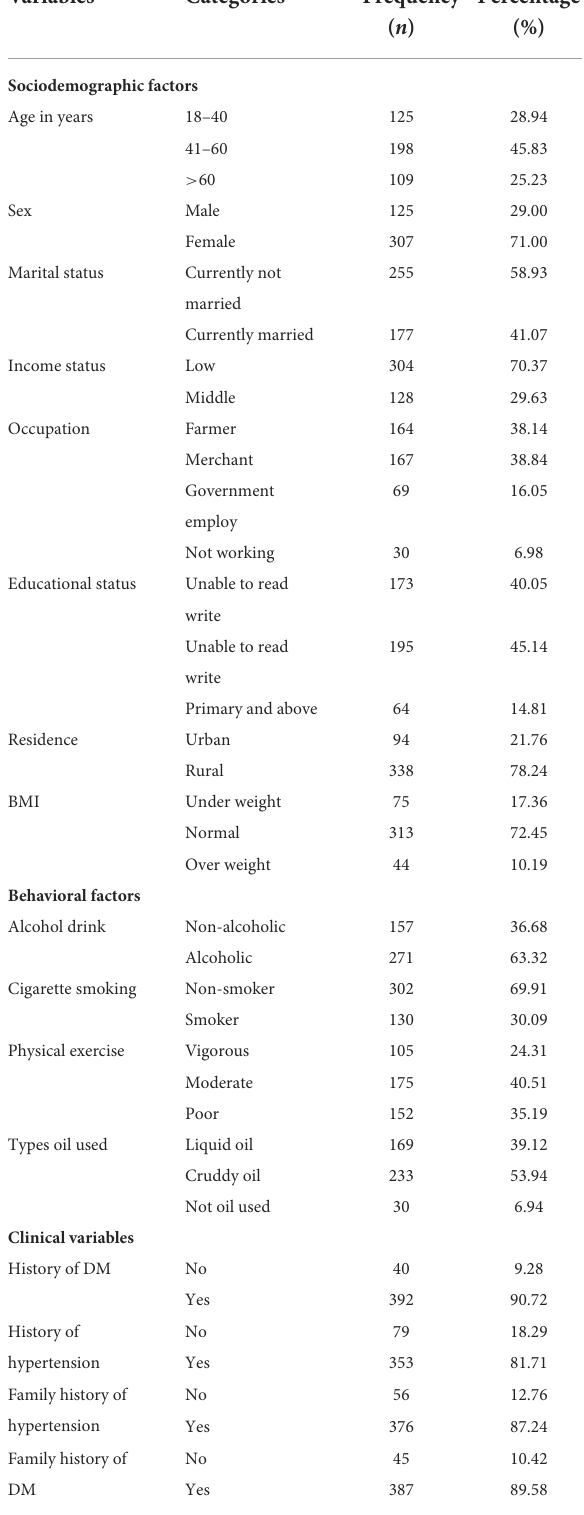
TABLE 2 Background characteristics of study subjects in a study of prevalence and associated factors of hypertension among adult patients evaluated at OPD in the Kiraker and Nigus Ketema primary hospitals, Northwest Ethiopia,